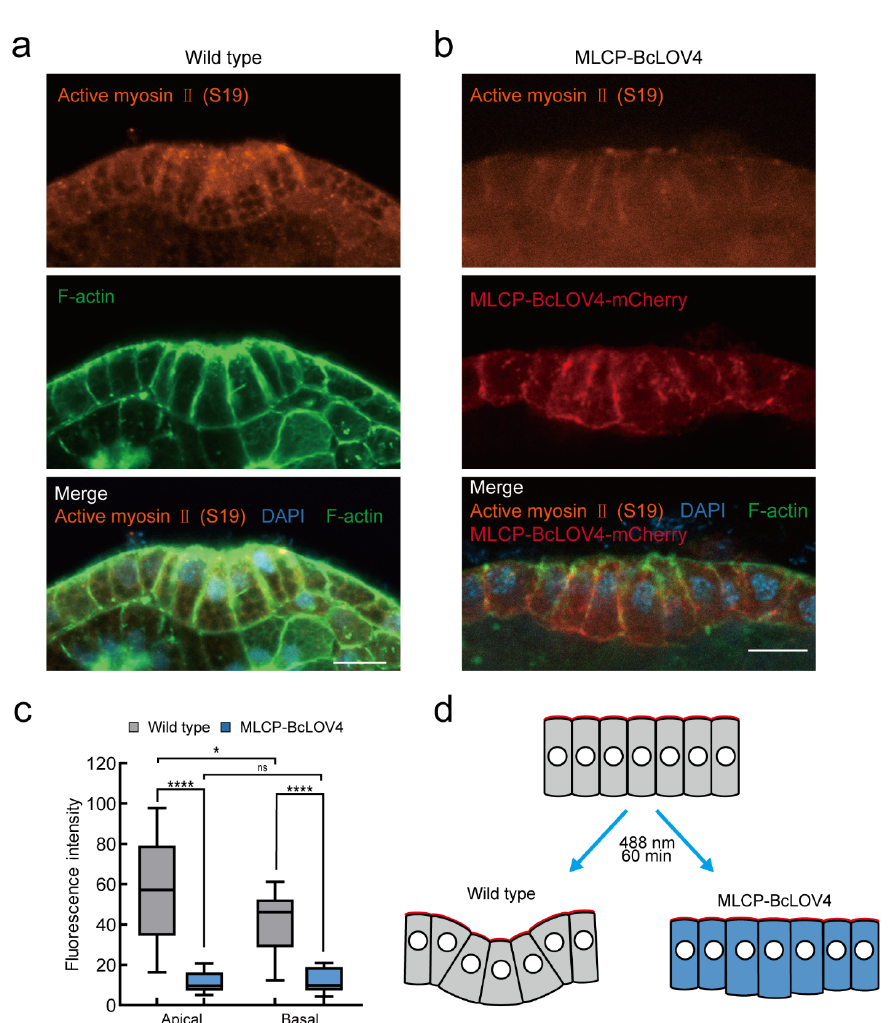
Figure 4. MLCP ‐ BcLOV4 system disrupted atrial siphon invagination via abolishing the apical contraction in Ciona larvae. ( a ) Representative image of myosin immunofluorescence assay of Ciona atrial siphon in wild type. Scale bar, 10 μ m; ( b ) Representative image of myosin immunofluorescence assay of Ciona atrial siphon in MLCP ‐ BcLOV4 system group. Scale bar, 10 μ m; ( c ) Quantification of fluorescence intensity of active myosin II signal of wild type and MLCP ‐ BcLOV4 ‐ expressed group after 60 min of exposure to 0.5% blue light. *, p < 0.05, ****, p < 0.0001 (student’s t ‐ test). n = 14 cells; ( d ) Schematic diagram of blue light treatment of Ciona atrial siphon of wild type and MLCP ‐ BcLOV4 ‐ expressed group. Red indicates the apical surface of the cell.